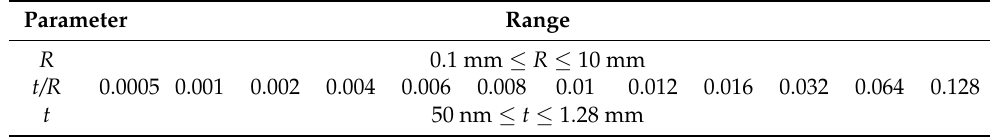
Table 1. Geometry parameter of the finite element